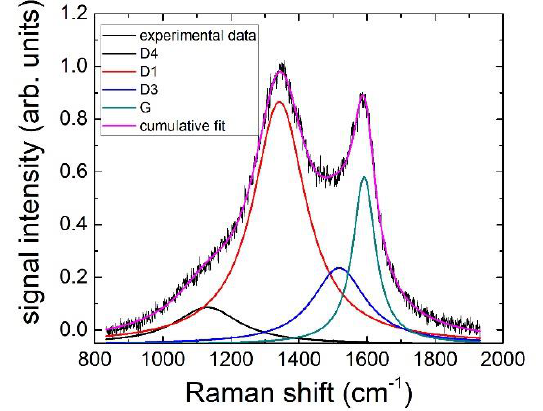
Figure 6. Morphology of the hard carbons after activation with KOH recorded at high magnification. ( Upper left ): apricot kernel, ( upper right ): cherry stone. ( Lower left ): olive stone, ( lower right ): walnut shell.